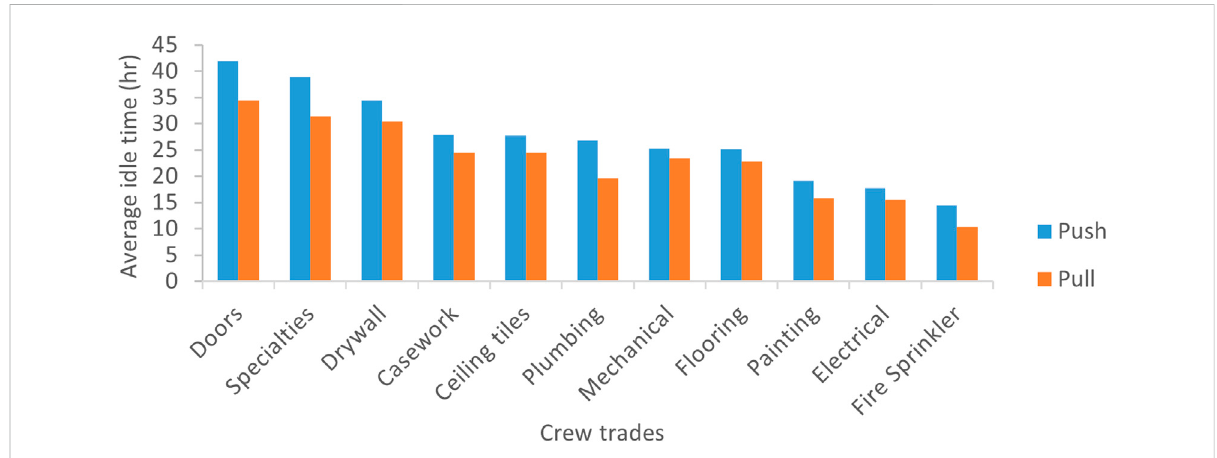
FIGURE 13 Average idle time for all crew types.